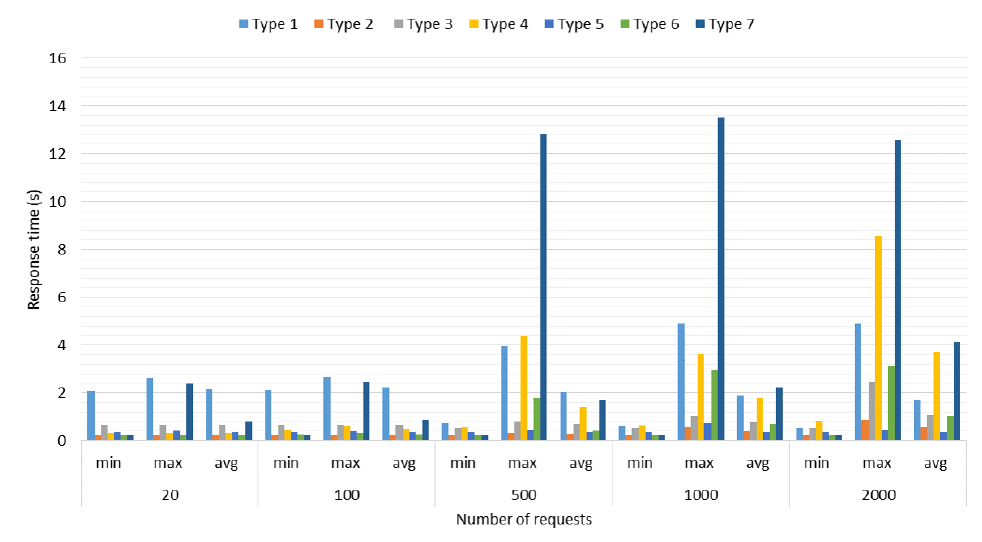
Figure 4. Response times with respect to the number of